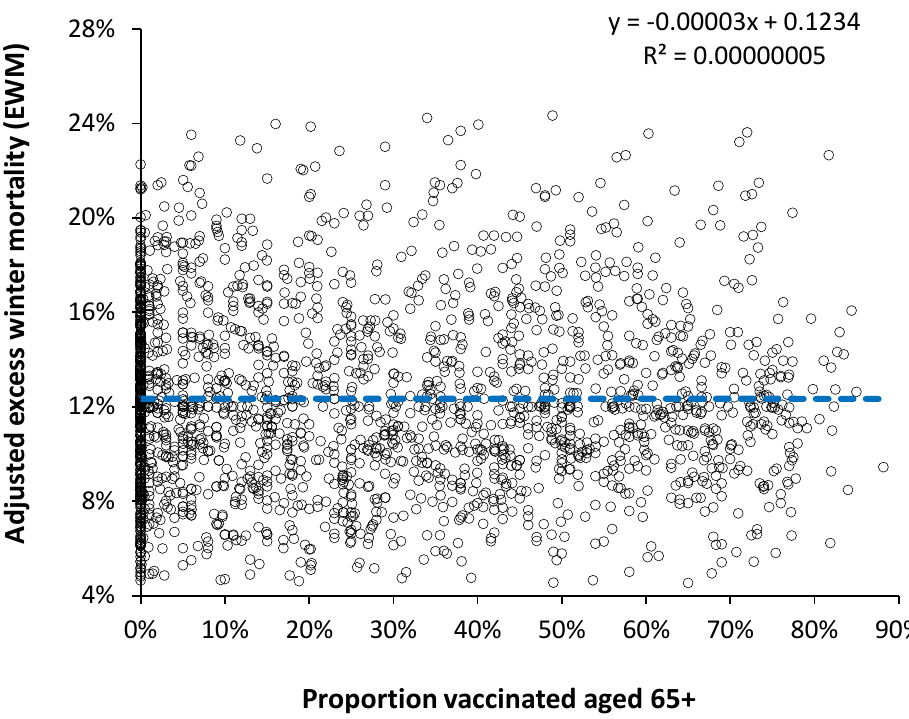
Figure 6. Adjusted EWM versus proportion aged 65+ vaccinated in 97 countries, 1988/89 to 2019/20.